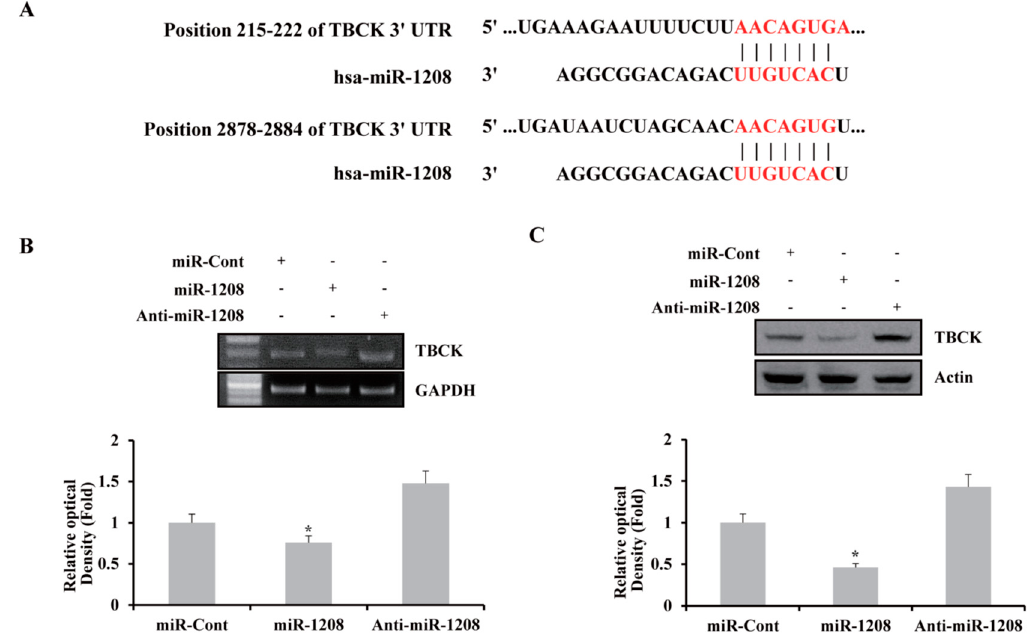
Figure 2. Identification of the gene regulated by miR-1208 in renal cancer cells. ( A ) miR-1208-binding sites in the 3 (cid:48) -UTR of TBCK mRNA. ( B ) RT-PCR analysis of TBCK mRNA expression in the miR-Cont- or miR-1208- or anti-miR-1208-transfected Caki-1 cells. The relative levels of each TBCK mRNA are expressed as the ratio of the densitometric value of each band to that of GAPDH ( bottom panel ). * indicates P < 0.05 compared to miR-Cont-transfected cells. ( C ) Immunoblots for TBCK protein in the miR-Cont or miR-1208 or anti-miR-1208 transfected Caki-1 cells. Actin was used as the loading control. The relative levels of each TBCK protein in miRNA-transfected cells are expressed as the ratio of the densitometric value of each band to that of actin ( bottom panel ). * indicates P < 0.05 compared to miR-Cont-transfected cells.